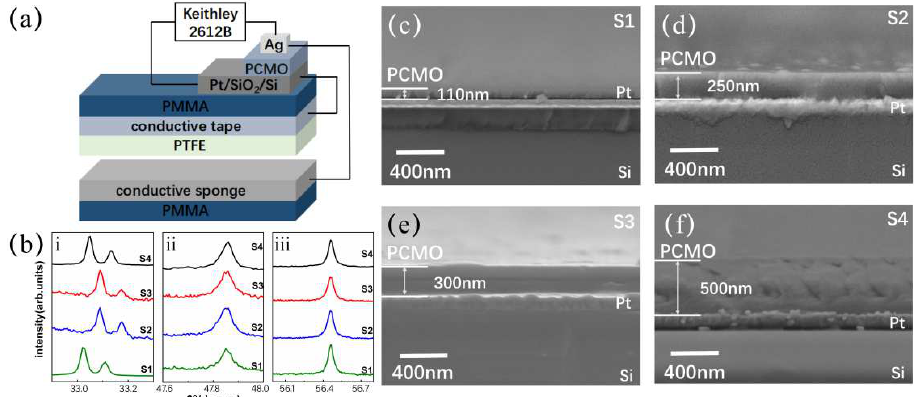
Figure 1. ( a ) Schematic illustration of self-powered RRAM; ( b ) XRD patterns of PCMO films deposited on Pt/SiO 2 /Si substrates at room temperature, and three main diffraction peaks are shown in (i), (ii), and (iii); ( c – f ) Cross-sectional SEM images of the four samples with PCMO of different thicknesses, ( c ) 110 nm, ( d ) 250 nm, ( e ) 300